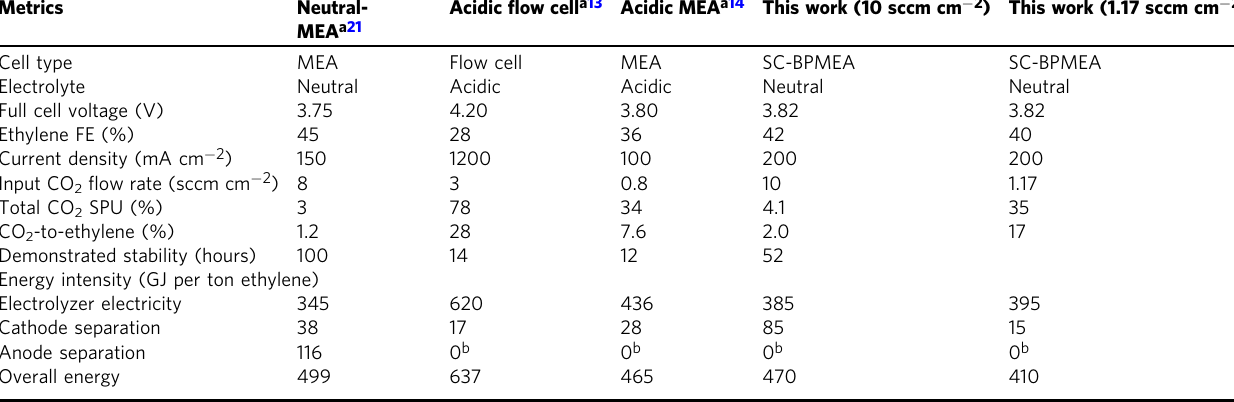
Table 3 Comparison of the energy intensity between various CO 2 -to-ethylene electrolyzers and this work.